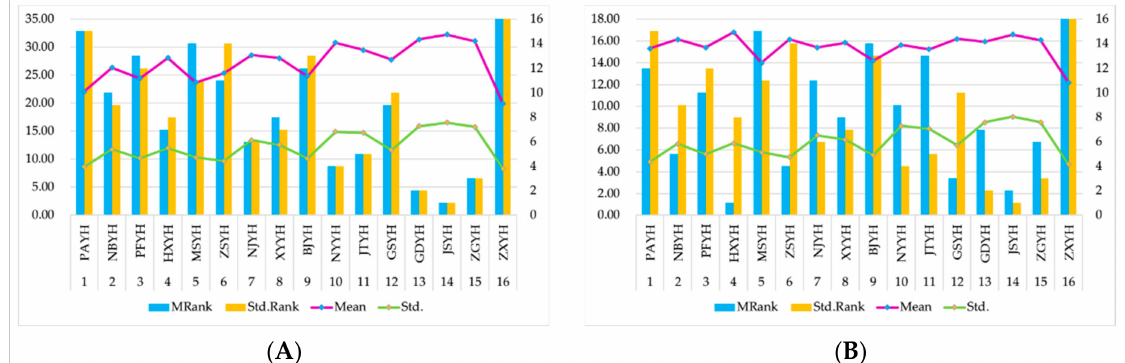
Figure 9. The results of the mean and standard deviations of ∆ CoVaR (In the figure, we calculate the daily ∆ CoVaR (the di ff erence between the Conditional Value at Risk (CoVaRs) when the bank is in distress and in a normal state) of each bank, and then derive the corresponding mean and standard deviation for each bank): ( A ) 2015; ( B )